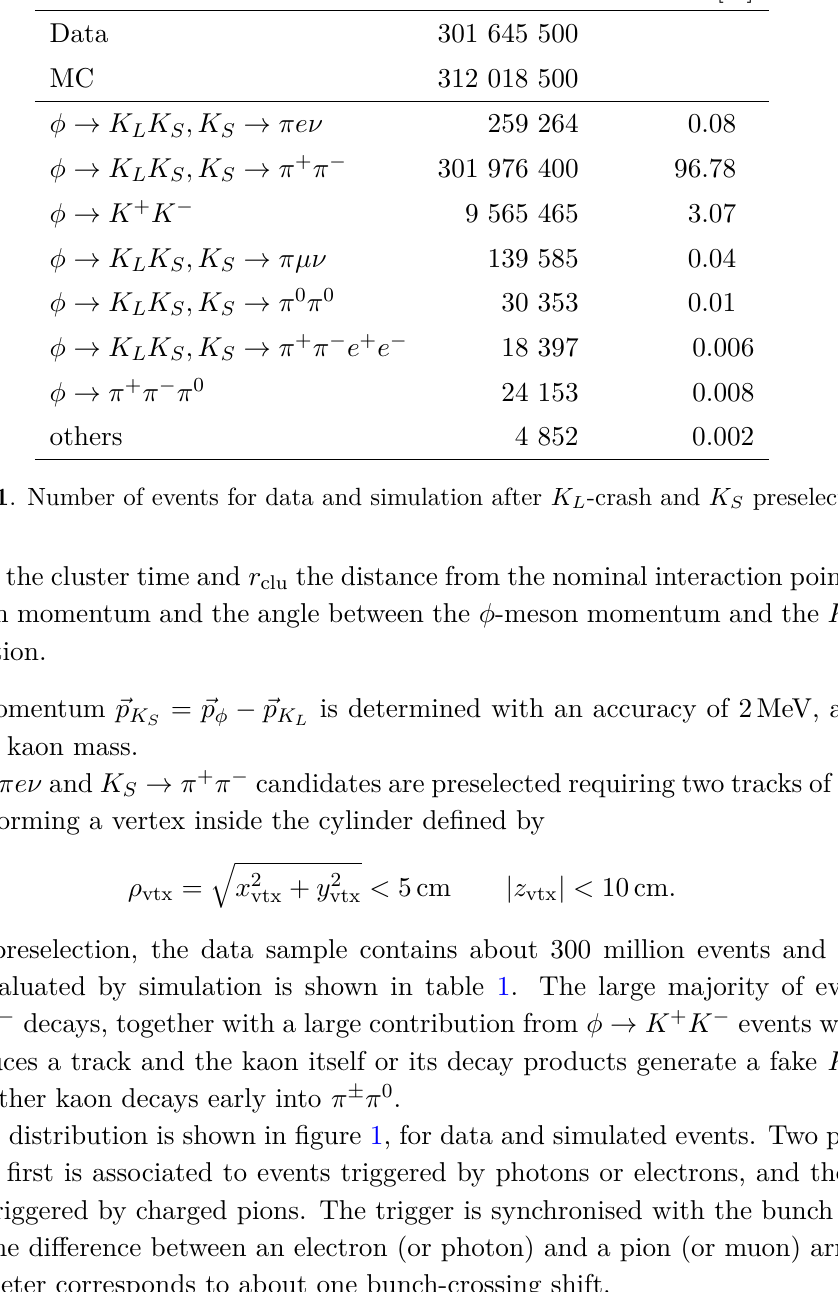
Table 1 . Number of events for data and simulation after K L -crash and K S preselection.